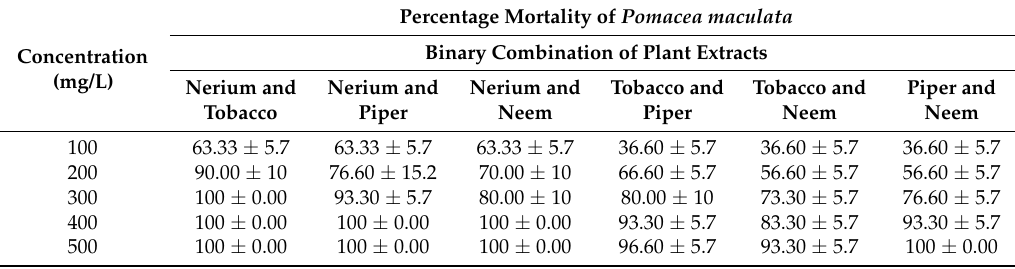
Table 5. Molluscicidal activity of six different binary combinations of plant extracts on P. maculata . Percentage Mortality of Pomacea maculata Binary Combination of Plant Extracts Concentration (mg/L) Nerium and Nerium and Nerium and Tobacco and Tobacco and Piper and Tobacco Piper Neem Piper Neem Neem 100 63.33 ± 5.7 63.33 ± 5.7 63.33 ± 5.7 36.60 ± 5.7 36.60 ± 5.7 36.60 ± 5.7 200 90.00 ± 10 76.60 ± 15.2 70.00 ± 10 66.60 ± 5.7 56.60 ± 5.7 56.60 ± 5.7 300 100 ± 0.00 93.30 ± 5.7 80.00 ± 10 73.30 ± 5.7 76.60 ± 5.7 400 100 ± 0.00 100 ± 0.00 100 ± 0.00 93.30 ± 5.7 83.30 ± 5.7 93.30 ± 5.7 500 100 ± 0.00 100 ± 0.00 100 ± 0.00 96.60 ± 5.7 93.30 ± 5.7 100 ± 0.00 Each value is Mean ± standard deviation (SD) of three replicates ( n =